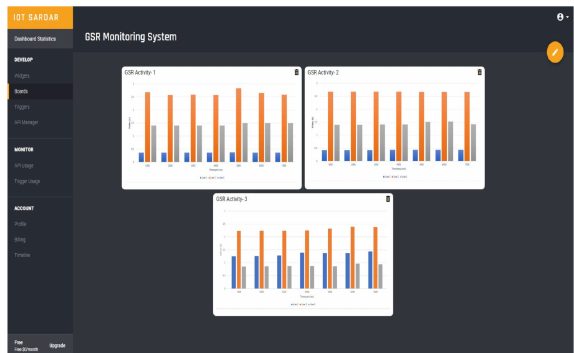
Figure 10. Data visualization in the cloud